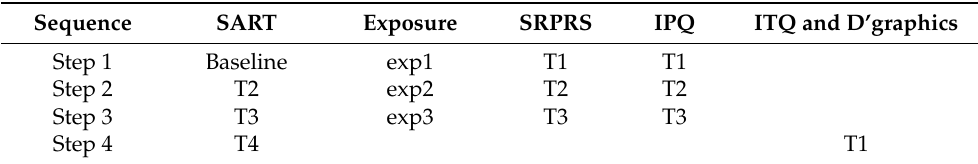
Table 1. Experimental